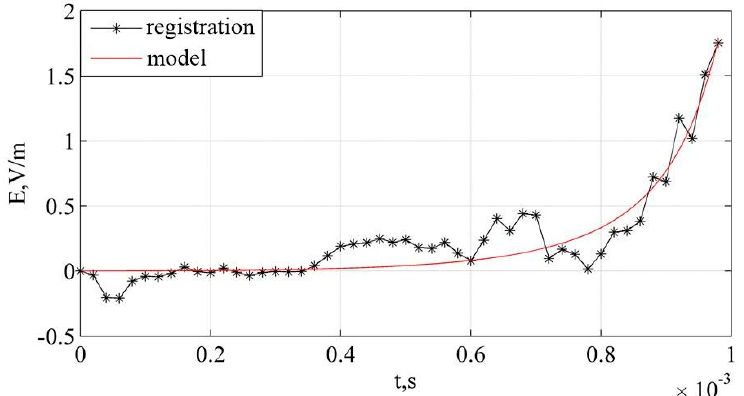
Figure 15. Description is the same as in Figure 10, except the distant positive lightning leader E-field change, which is related to Case #12 from Table 1 (see Figure 9).